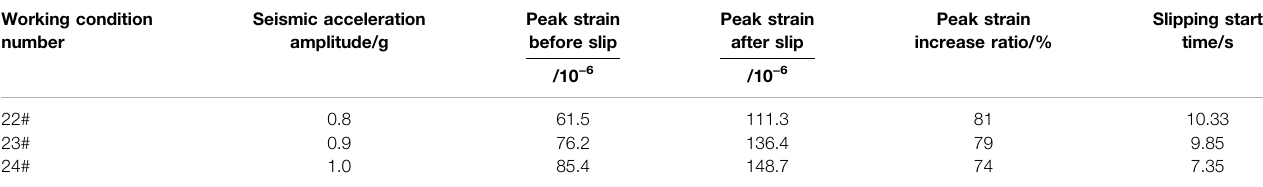
TABLE 4 | Peak strain of the anti-seismic anchor cables in instantaneous slip situation. Working condition number